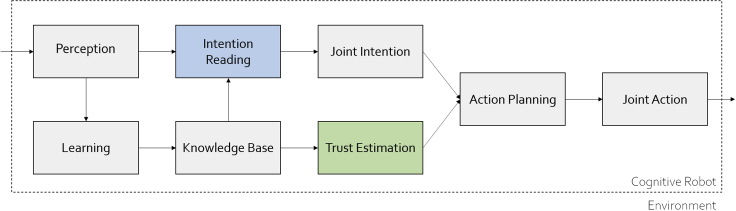
Overview of the mechanisms leading to joint actionExpanded from Bauer et al. (2008) through the addition of trust estimation.